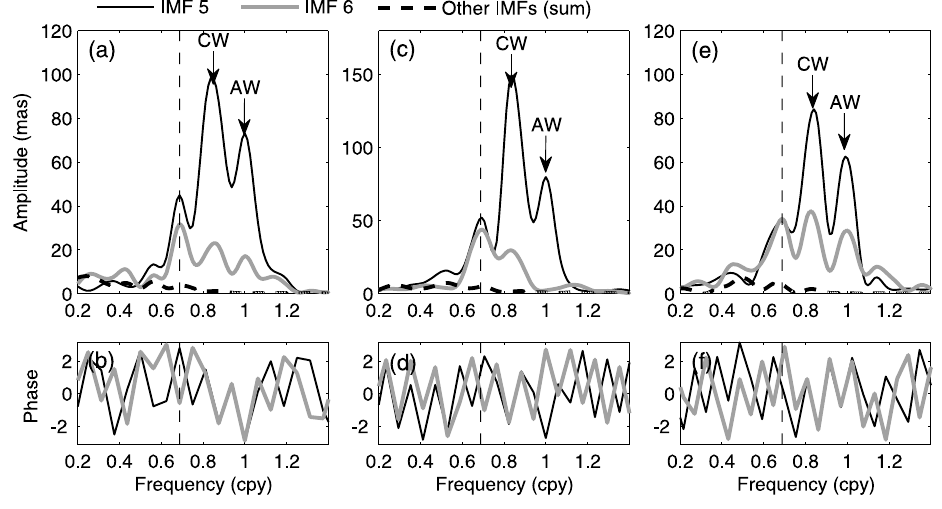
Figure 5. Same as Fig. 4 but for the y -components of the three sub-series. Table 3. The chosen amplitudes of the CW (0.8437cpy) and AW (1cpy) for the synthetic series, and the corresponding estimated values from the synthetic series. (Unit: mas.) M Synthetic (input) Synthetic (output) CW AW CW AW 531dW